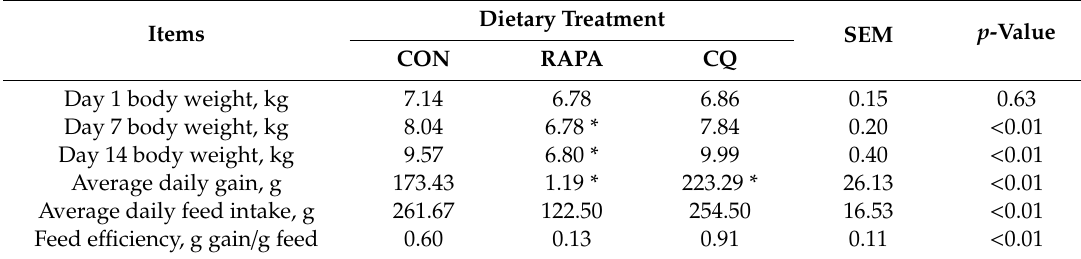
Table 2. Growth performance of